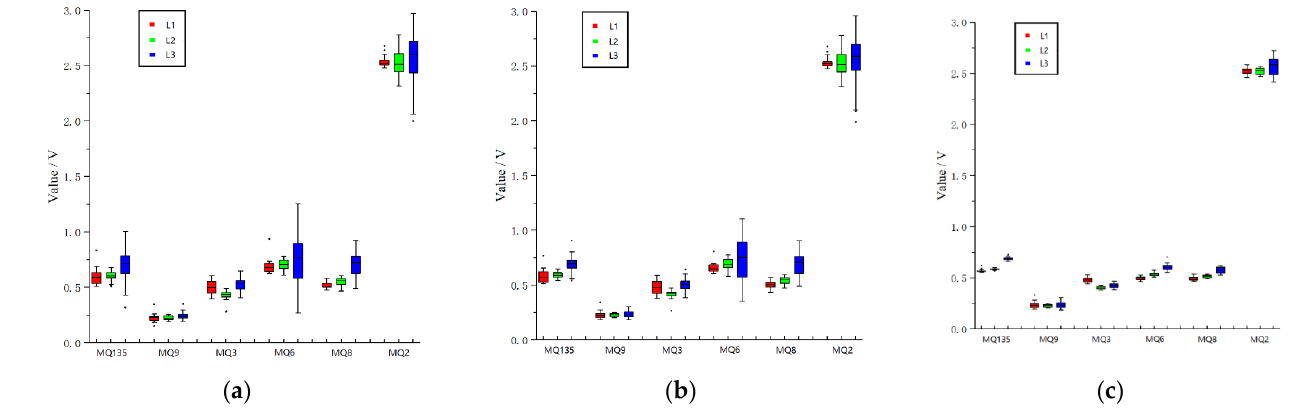
Figure 11. The features of Sensor MQ-8 extracted from the pre-processed curve.